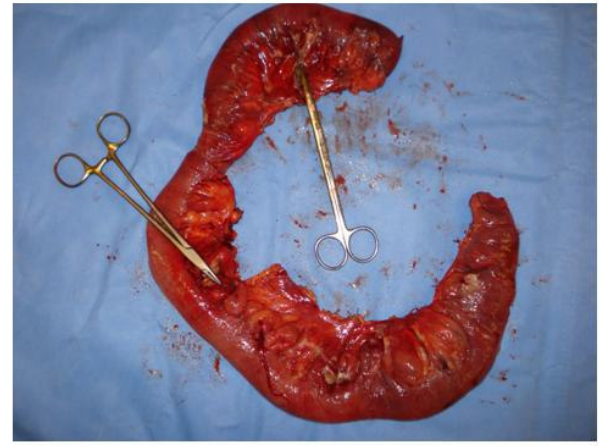
FIGURE 6. Resected jejunum containing multiple jejunal diverticula identified by the tip of the needle holder and rupture of one of them identified by the tip of the scissors.